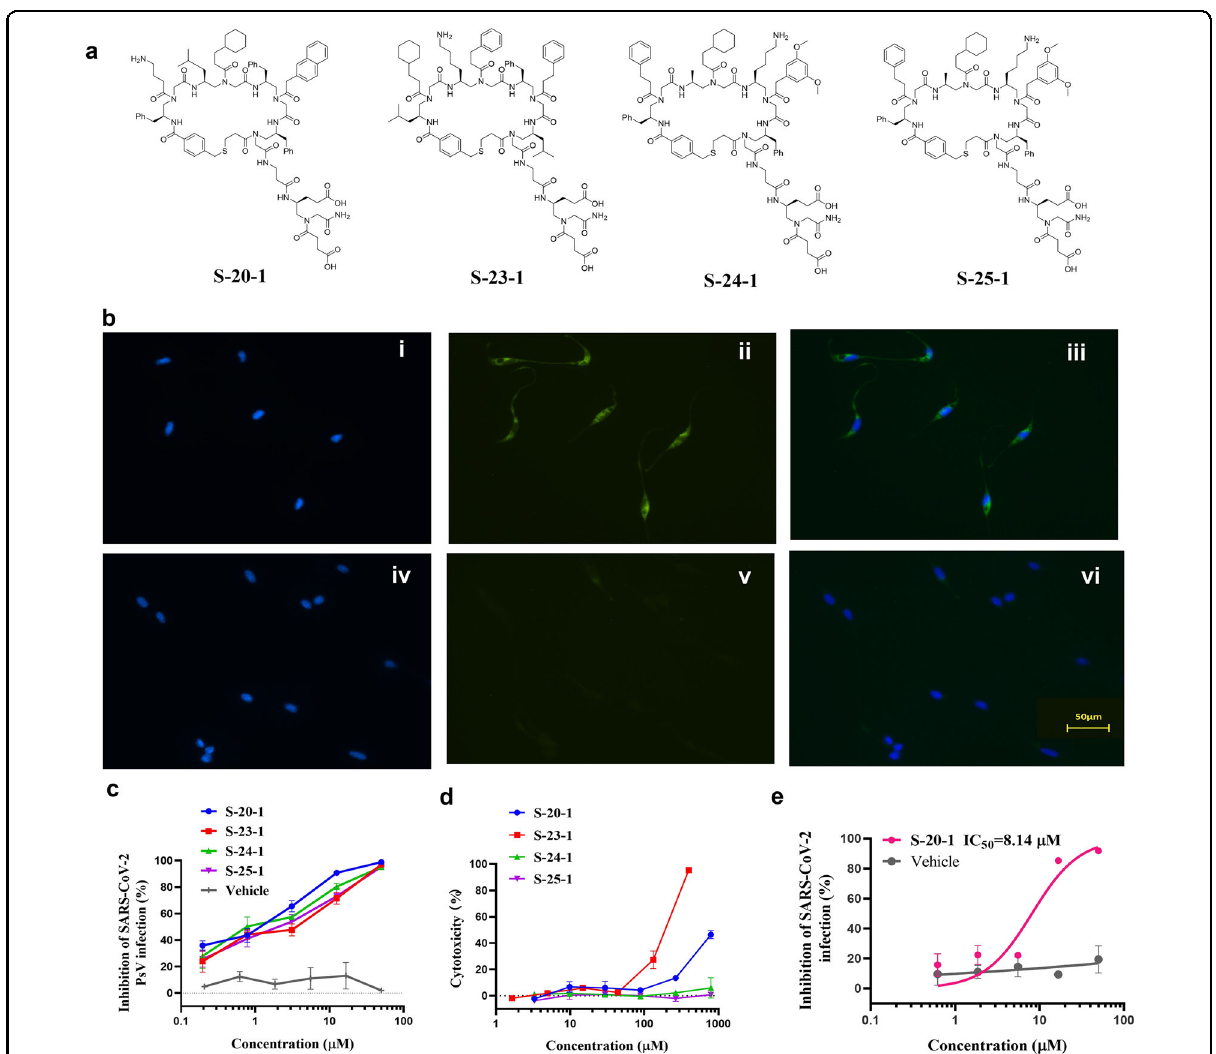
Fig. 2 Identi fi cation of four modi fi ed cyclic γ -AApeptides with improved SARS-CoV-2 fusion/entry inhibitory activity and SI. a Chemical structures of four modi fi ed hits. b HeLa cells incubated with FITC labeled S-20 (i – iii) and FITC labeled S-20-1 (iv – vi) at 1 μ M for 2 h, respectively, and then stained with DAPI. (i, iv) DAPI channel; (ii, v) FITC channel; (iii, vi) merged. c Inhibitory activity of 4 modi fi ed cyclic γ -AApeptides in PsV infection assays against SARS-CoV-2. d Cytotoxicity of 4 modi fi ed cyclic γ -AApeptides on Huh-7 cell line. e Inhibitory activity of S-20-1 on authentic SARS-CoV- 2 replication on Caco-2 cell